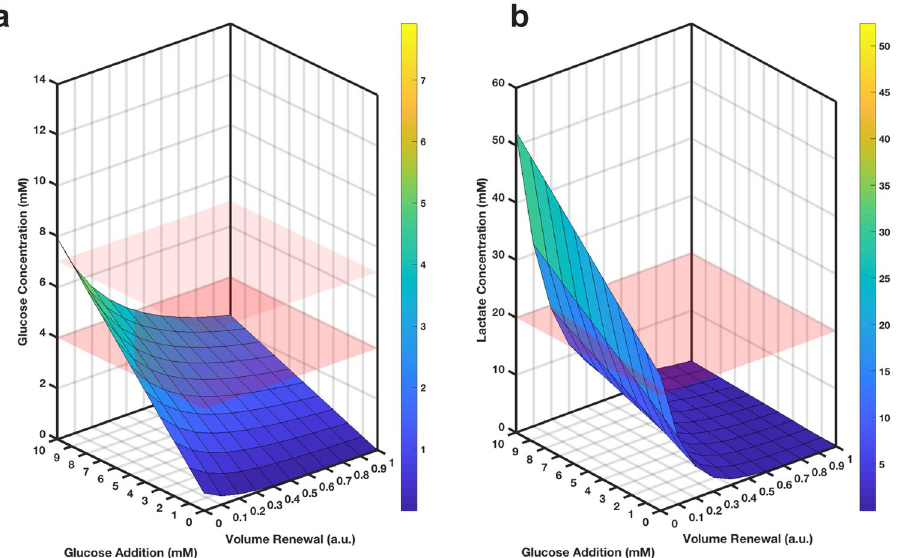
Figure 4. Simulating media change protocols to achieve quasi-steady state operations in the gut MPS. Simulating a range of medium change protocols allows identification of operational strategies that can simultaneously satisfy the desired conditions: ( a ) glucose within physiological levels (between red planes: 4–7 mM) and ( b ) lactate levels below toxic concentrations (below red plane: 20 mM). Media change protocols simulated were replacement of media volume every 24 h from the basal side (0-100%, 10% steps) and supplementing glucose every 24 h to the apical site (0–10 mM, 1 mM steps) for 10 days, with the final glucose and lactate concentrations represented by the simulated surfaces. The color of the simulated surface corresponds to the colorbar on the right-hand side and to values on the z-axis, i.e. represents glucose ( a ) and lactate ( b )